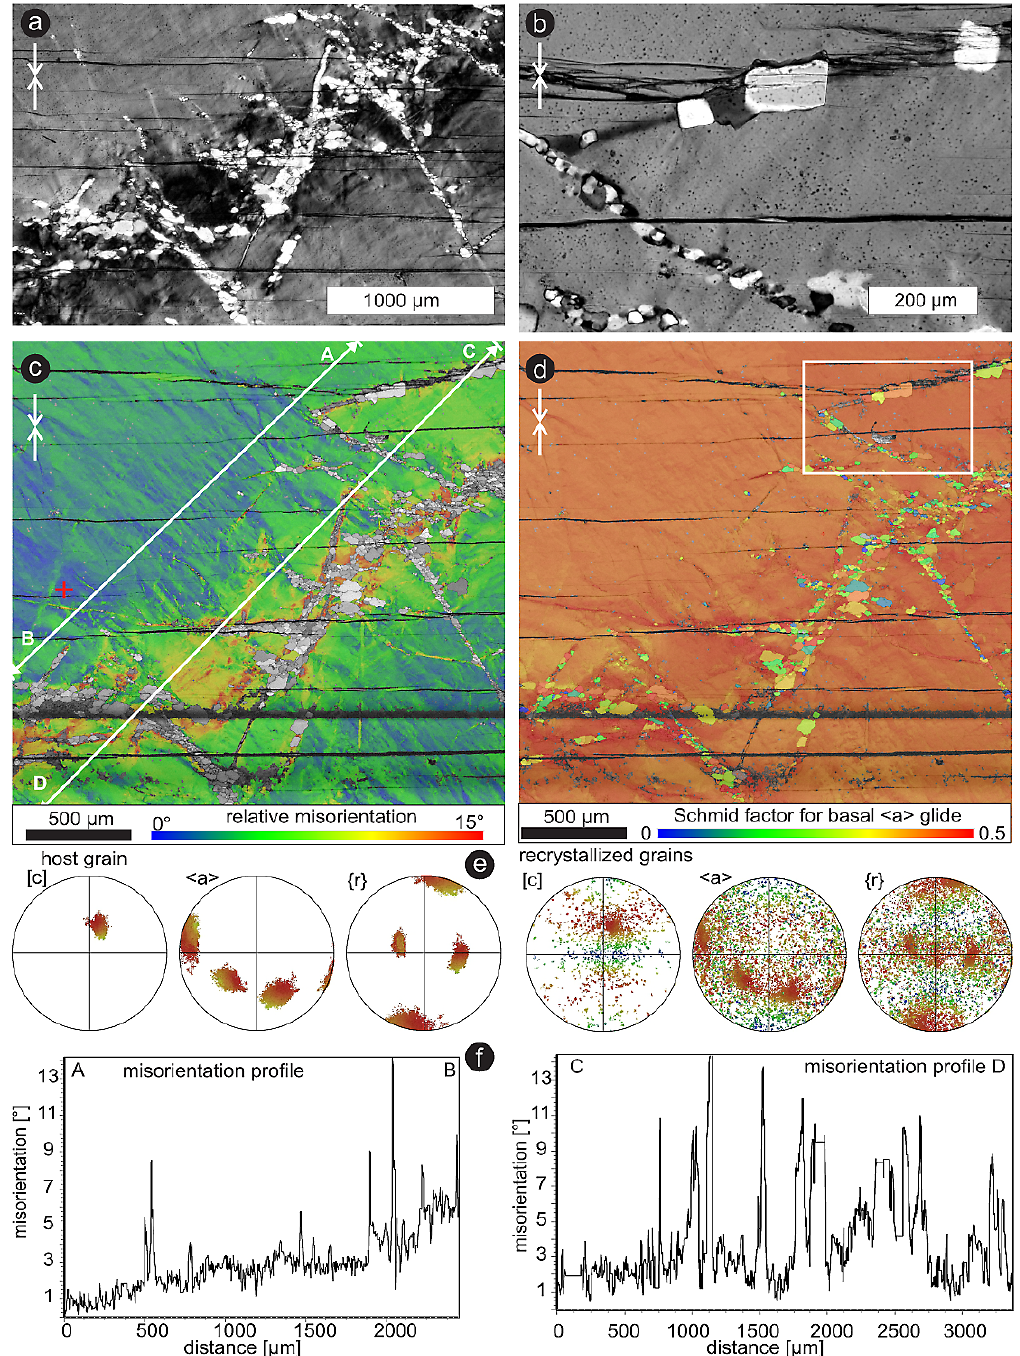
Fig. 5. Quartz microfabric after “kick and creep” experiment CR1-16, initially deformed at 400 ◦ C, 2GPa confining pressure, strain rate 10 − 4 s − 1 , and afterwards at 900 ◦ C, 2.5GPa confining pressure, undergoing stress relaxation. The shortening direction is indicated by white arrows. (a, b) Polarized light micrographs showing bands of recrystallized grains and pronounced SWUE. (c) EBSD map showing misorientation relative to reference point (red cross); colours indicate relative misorientation, displayed as overlay on band contrast image in grey shades; non-coloured areas are not indexed. White lines indicate location of misorientation profiles shown in (f) . (d) EBSD map showing Schmid factor for basal < a > glide. White rectangle indicates location of polarized light micrograph in (b) . (e) Pole figures showing crystallographic orientation of host grain and recrystallized grains, respectively. (f) Misorientation relative to first points (A and C) along white lines displayed in (b)